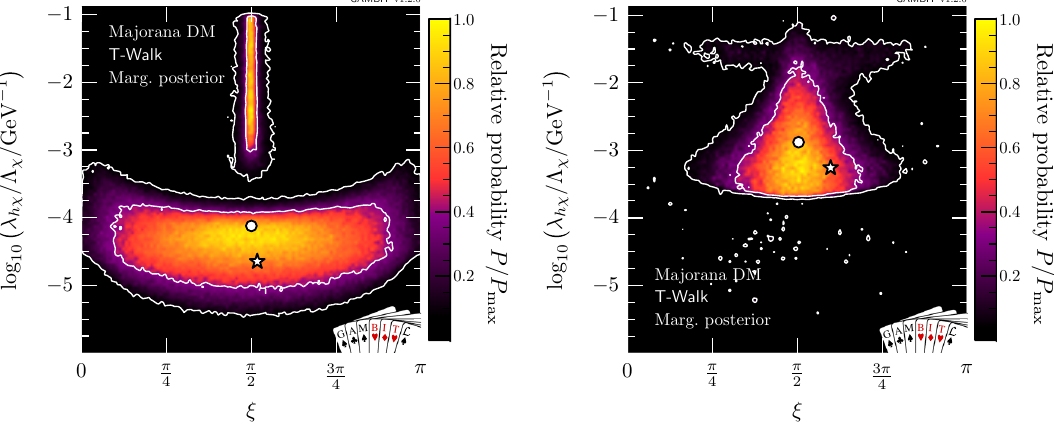
Fig. 10 Marginalised posterior distributions in the (λ h χ /Λ χ ,ξ) plane for Majorana fermion DM. Contour lines show the 1 and 2 σ credible regions. The left panel gives the result of a scan restricted to the reso-